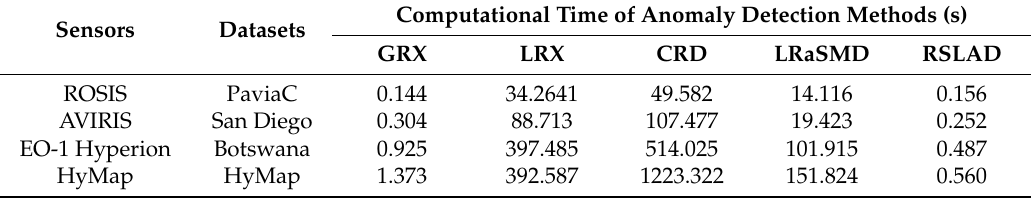
Table 2. The Computations Times of RSLAD and Other Four Methods on the Four